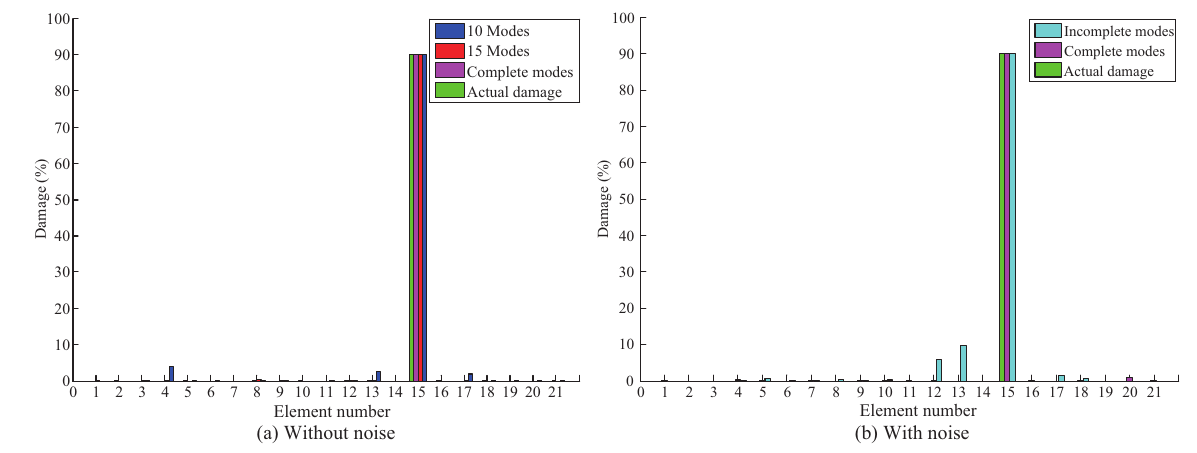
Fig. 7. Damage distribution of Belgian truss using the complete and incomplete modal data in Scenario 1.